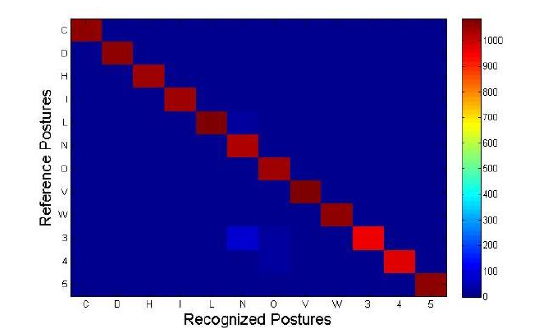
Figure 10. Confusion